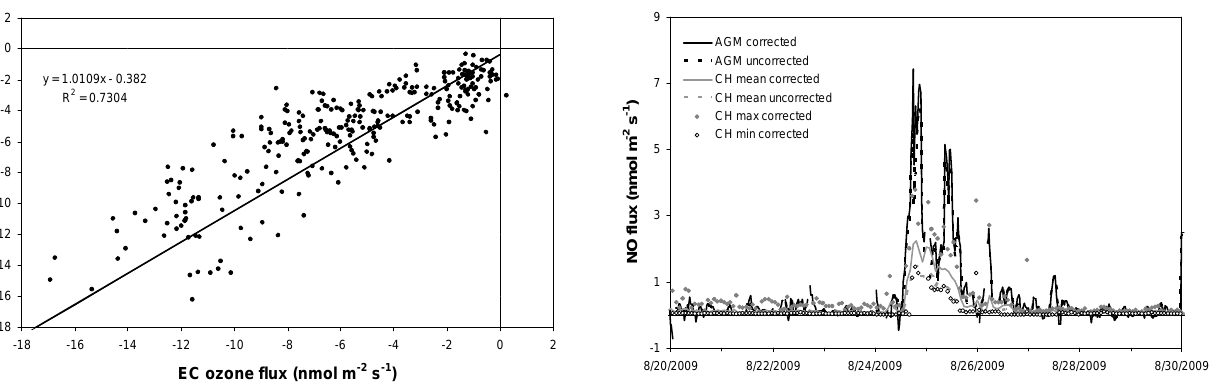
Figure 10: Comparison between NO fluxes measured by the aerodynamic gradient method 15 Fig. 10. Comparison between NO fluxes measured by the aerody- (black line) and automatic chambers (grey line). Solid and dotted lines are fluxes with and 16 namic gradient method (black line) and automatic chambers (grey without corrections for chemical reactions, respectively. Grey and open symbols are 17 line). Solid and dotted lines are fluxes with and without corrections respectively maximal and minimal NO fluxes measured by automatic chambers. 18 for chemical reactions, respectively. Grey and open symbols are re- spectively maximal and minimal NO fluxes measured by automatic